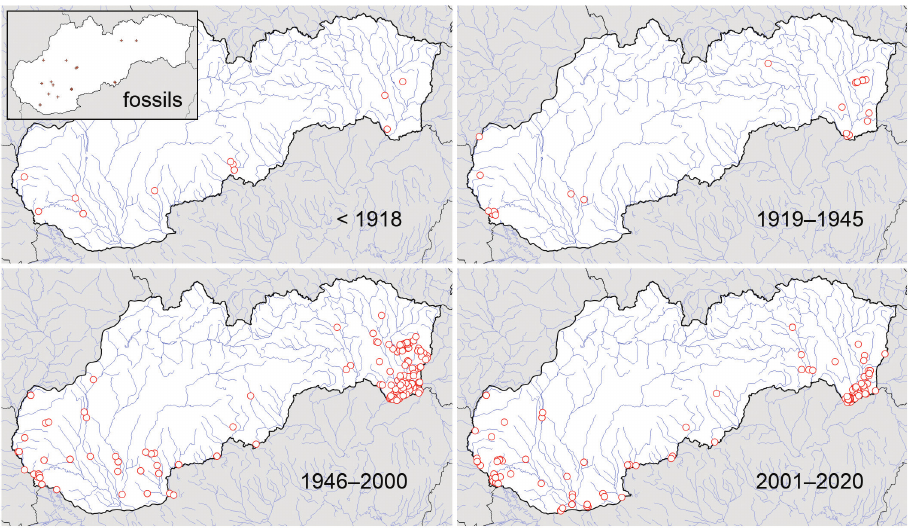
Figure 1. Distribution range of E orbicularis in Slovakia. The division into periods follows the phasing of herpetological research in Slovakia (Uhrin et al. 2019), the range based on fossil records originating from the Pliocene up to the Holocene (for source references, see the Suppl. materials